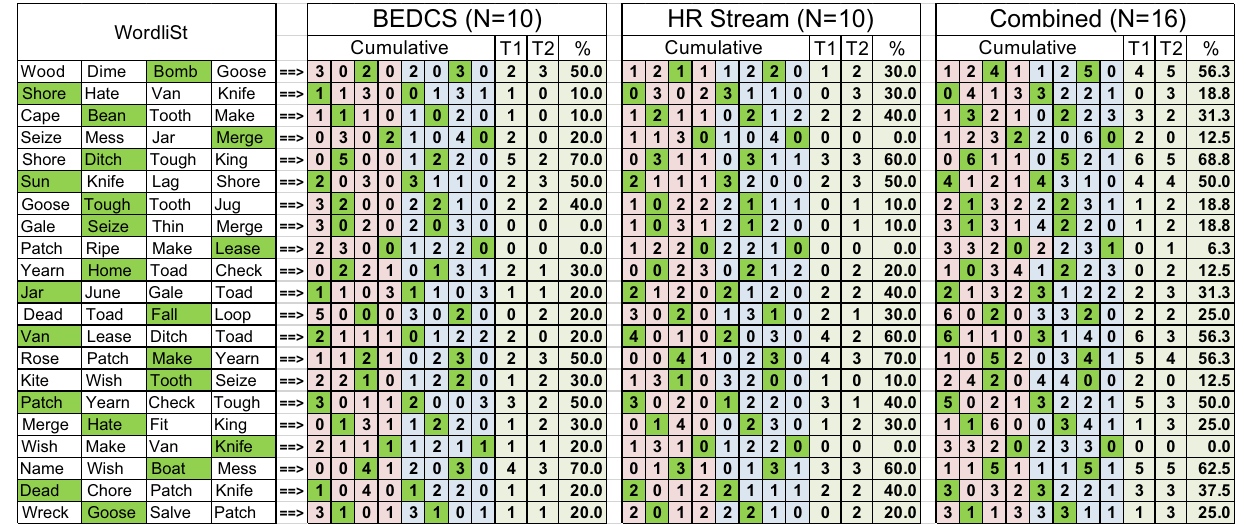
Table 1. The left four columns show the 21 sets of four words shown to the test subject. The word with the green background is the correct word in a set of four, matching with the information presented to the test subject via their cochlear implant. Words selected by the test subject are shown in the cumulative tables for the BEDCS, the HR-Stream, and the combined data. N indicates the number of times a word set is included in the analysis. For example, for the BEDCS system (N = 5), test subjects × 2 presentations of a word set, which equals 10. No feedback has been given to the patient on the correct answer. Therefore, the presentation of the same set twice was considered independent. For the nine columns assigned to each, “BEDCS”, “HR-Stream”, and “combined” the following applies: The four columns with the red backgrounds show the frequency a word was selected in trial 1 (T1), and the four columns with the blue background show how often a word was chosen in trial 2 (T2). The column with the header “T1” counts how often the correct word was selected in trial 1, the column with the heading “T2” shows the number of correct words selected in trial 2. The rows in the column “%” show the overall percentage correct for a given